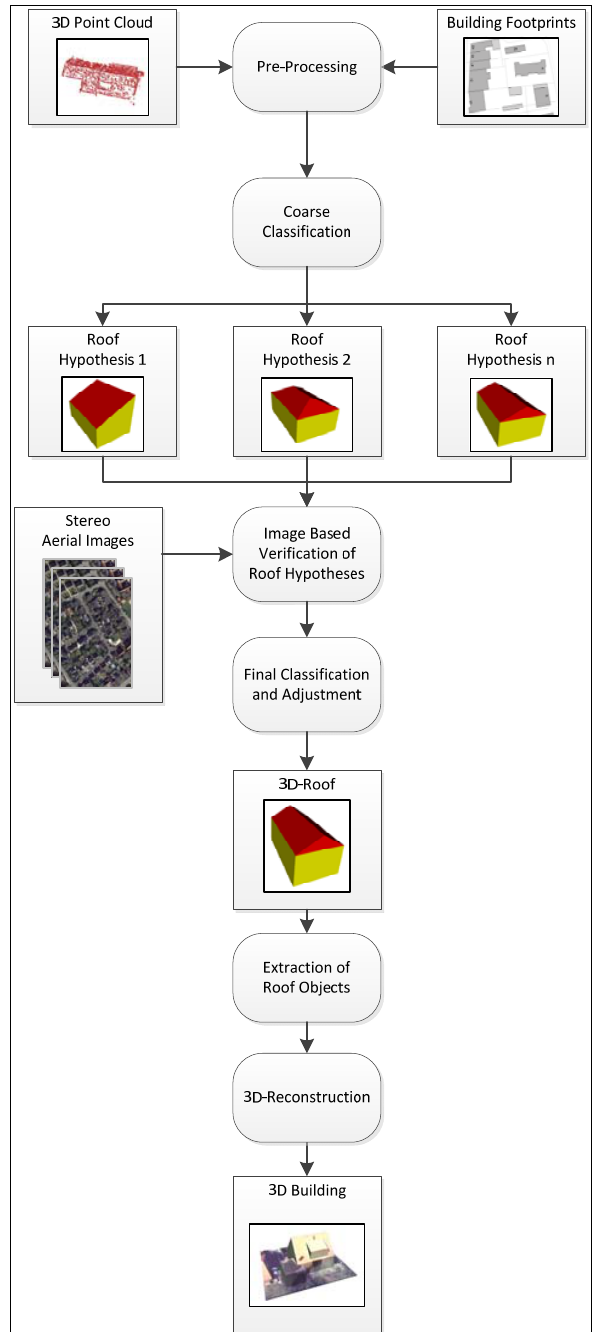
Figure 1. System